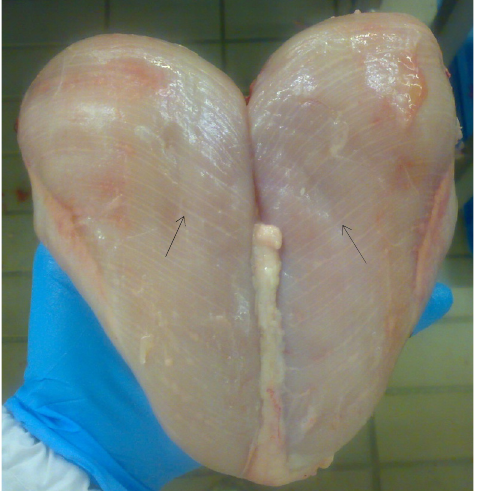
Figure 4. Broiler breast meat with “white striping”